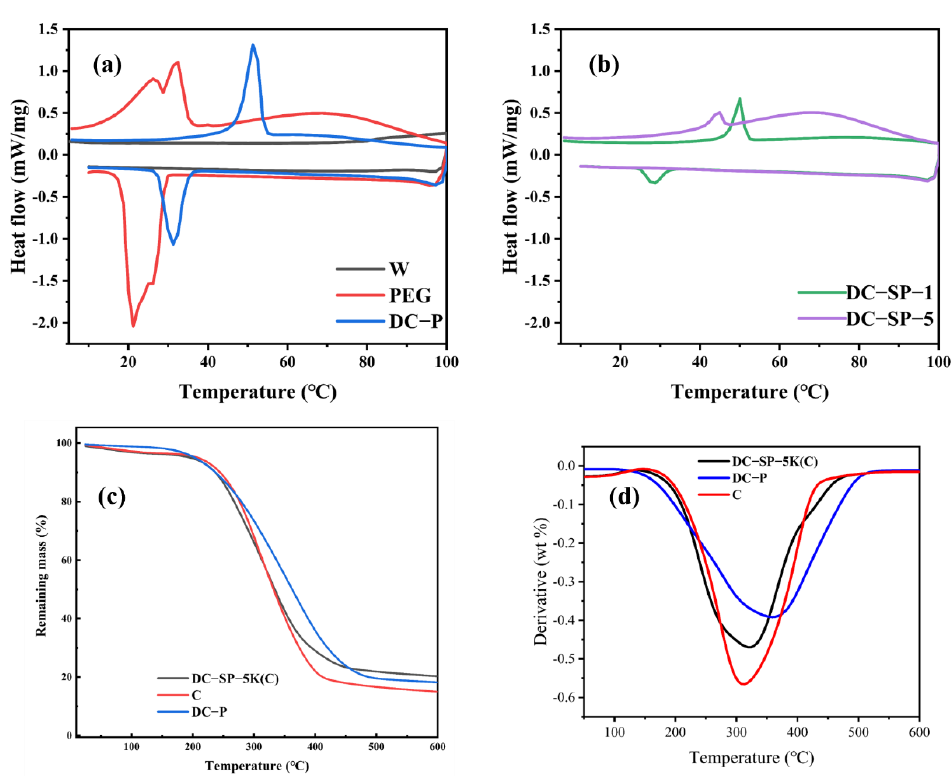
Figure 4. Comparison of DSC, TG, and DTG of samples. ( a ) DSC patterns of W, PEG, and DC-P; ( b ) DSC patterns of DC-SP-1 and DC-SP-5; ( c ) TG patterns of C, DC-P, and DC-SP-5K(C); ( d ) DTG patterns of C, DC-P, and DC-SP-5K(C).